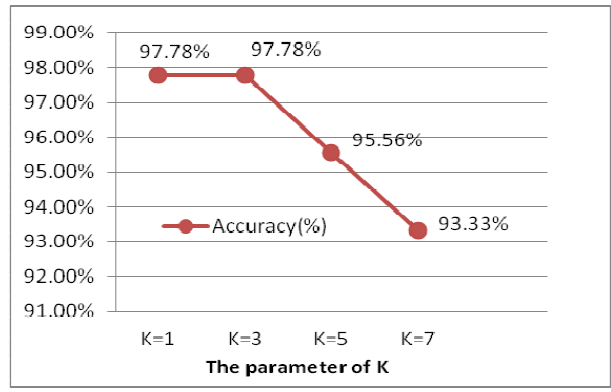
Figure 28. Comparison of different